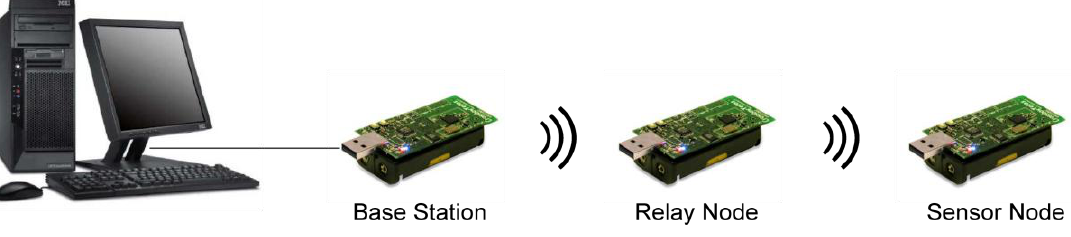
Figure 3. Topology for a two-hop network. In round-trip delay time tests, the base station sends ping requests to the sensor node. In end-to-end delay time tests, the sensor node originates the UDP packet flows. Current consumption is measured in the relay